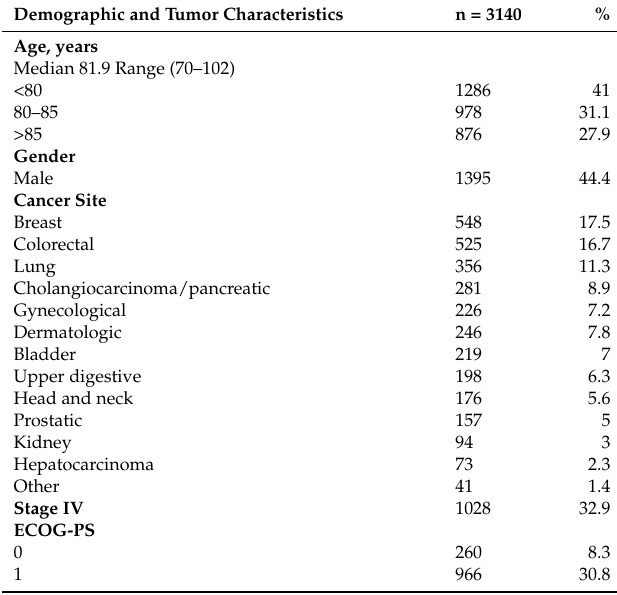
Table 1. Demographic and tumor